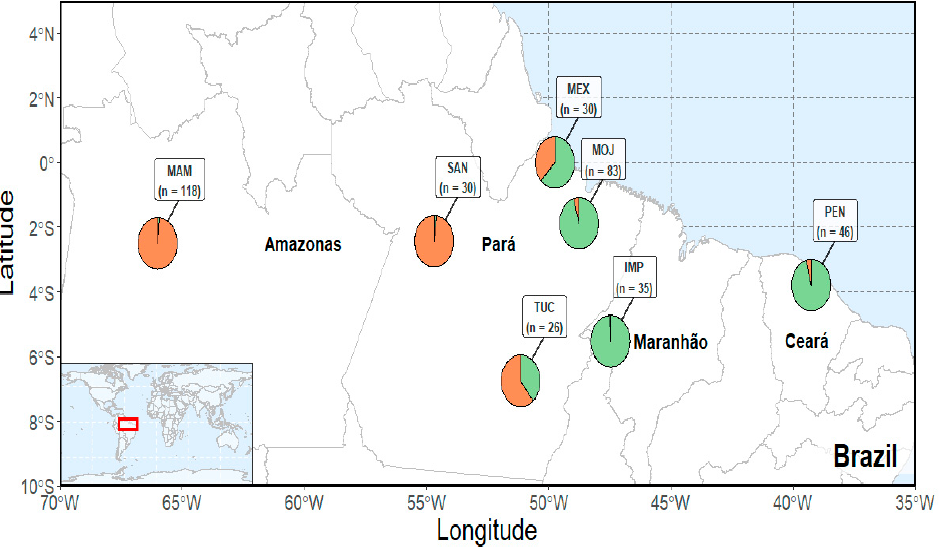
Figure 1. Map of collecting localities of Arapaima gigas . Pie plots indicate average population ancestry of each of the three main biological clusters detected in STRUCTURE analysis (see Figures 2 and 3). Color scheme is same as in Figure 2.